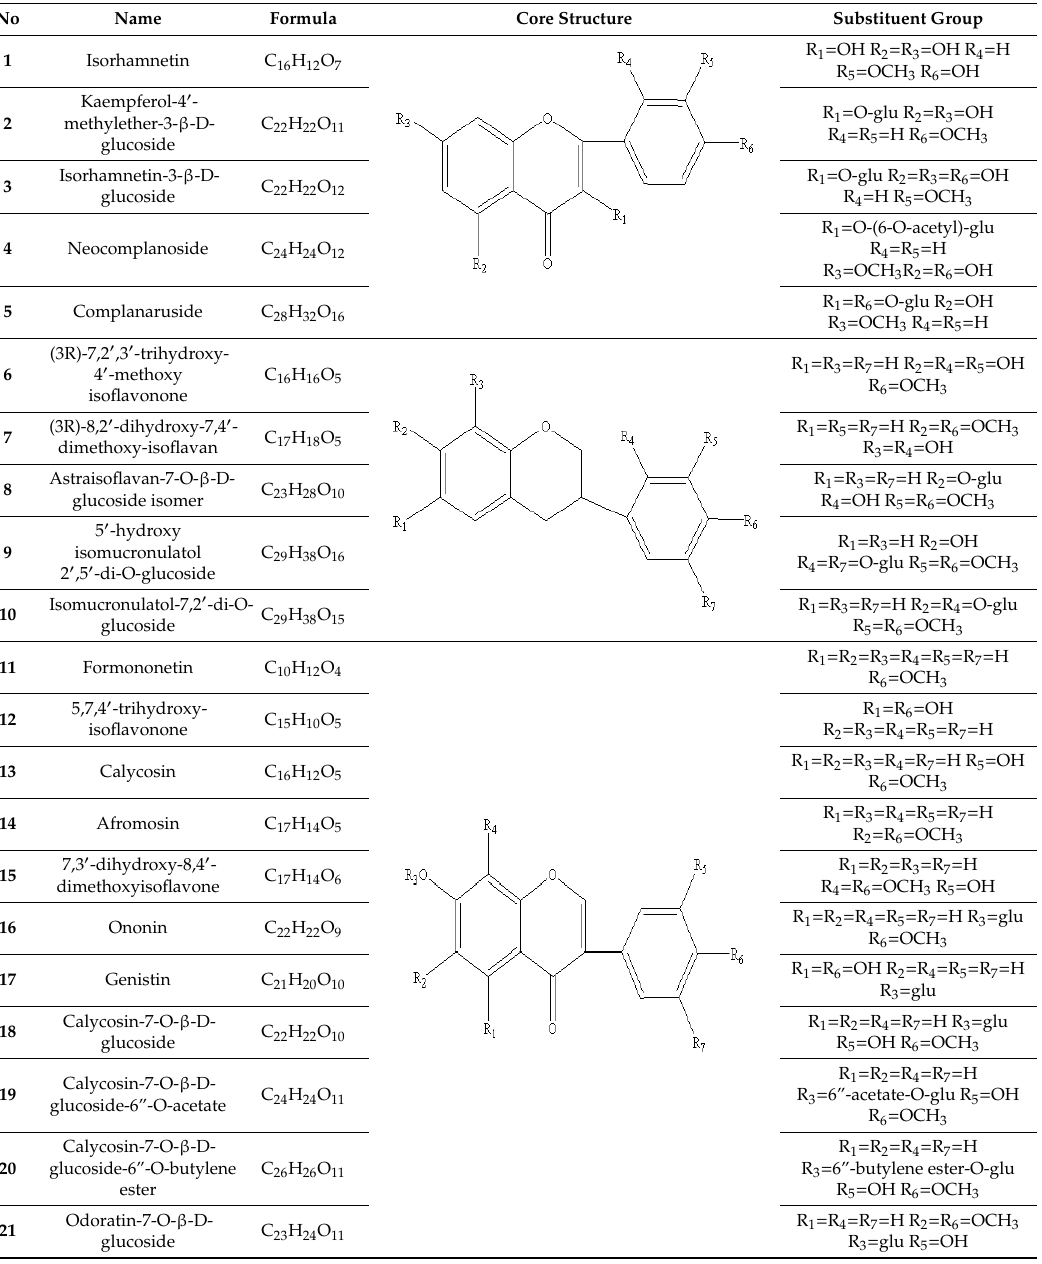
Table 4. Chemical information of identified flavonoids in AR and FAR.